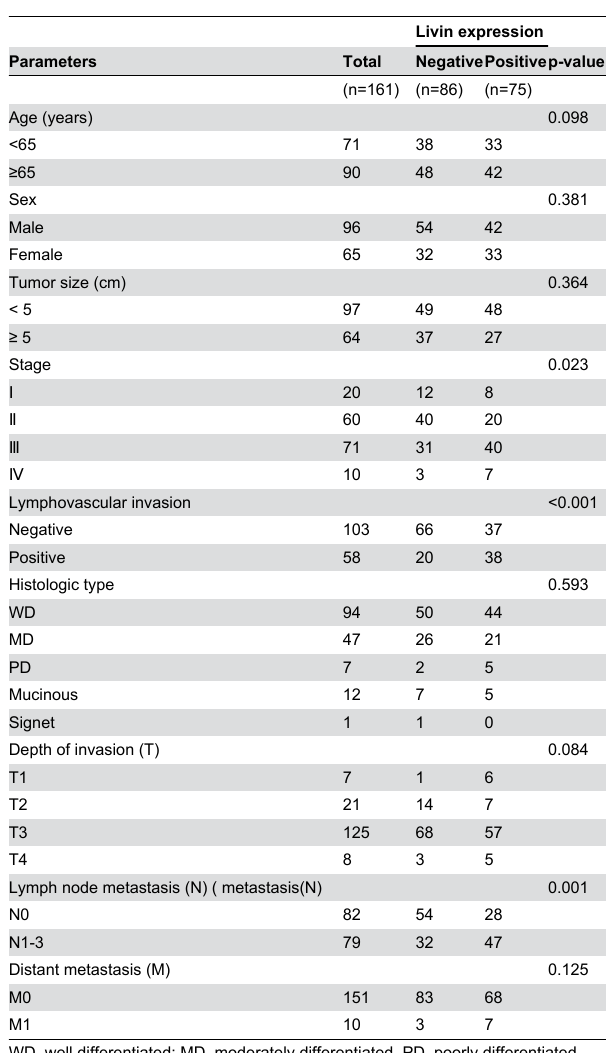
Table 2. Correlation between Livin expression and the clinicopathological parameters of patients with colorectal